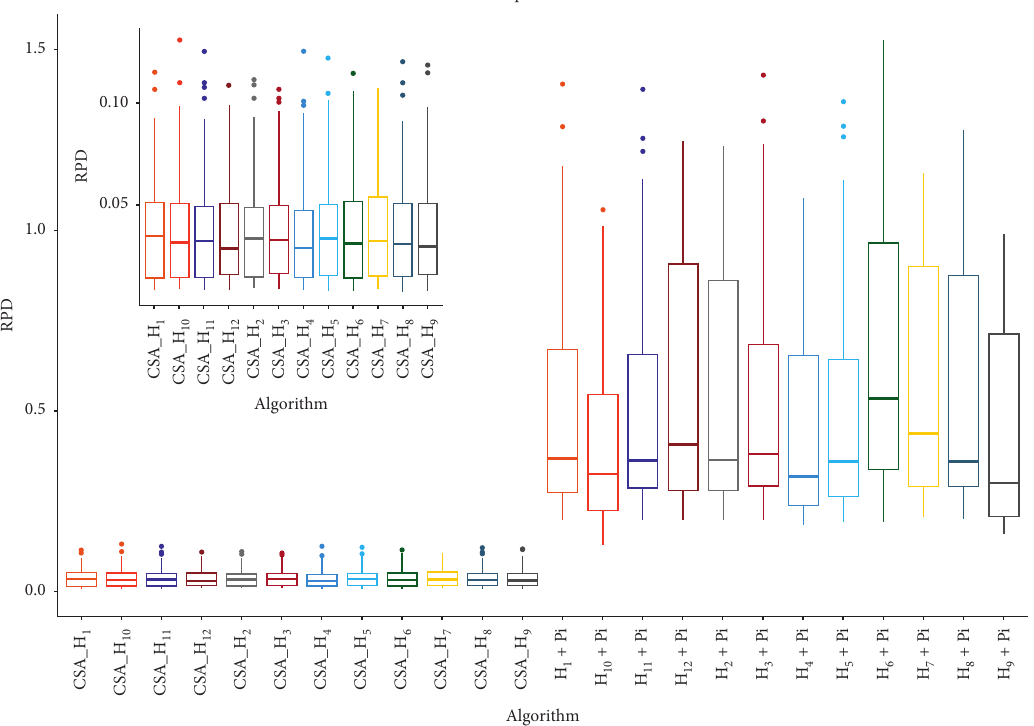
Figure 5: The boxplots of 12 heuristics and 12 CSA-Hs algorithms (large n ).